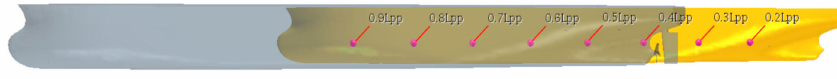
Figure 8. Distribution of pressure-measuring points for the case of ξ′ 0.8 .